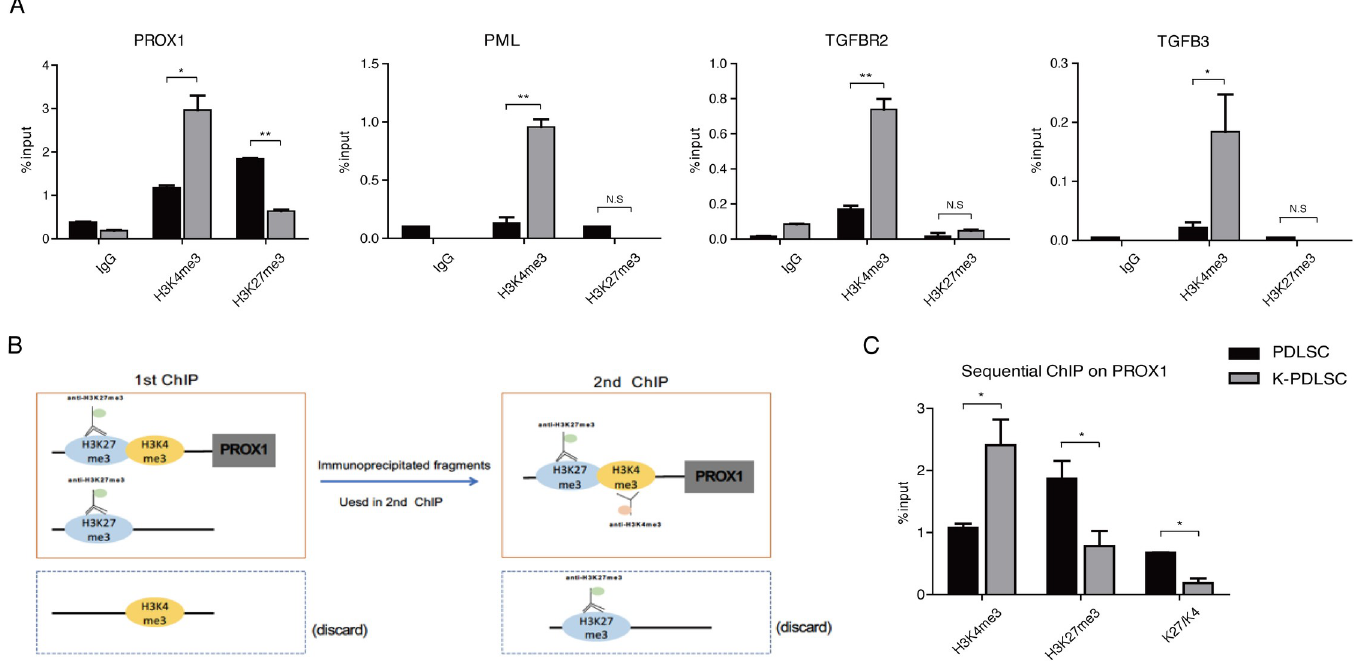
Fig 3. PROX1 gene is harbored in a bivalent chromatin structure and KSHV infection can resolve it to activate PROX1 expression. (A) Mock- and KSHV-infected PDLSCs were subjected to a Chromatin immunoprecipitation (ChIP) assay with antibodies against H3K4me3 and H3K27me3. The extracted DNA was analyzed by qPCR for the PROX1 promoter region and other MEndT-related genes, including PML, TGF- β R2 and TGF- β 3. PROX1 gene in mock-infected PDLSCs heavily consists of both active mark H3K4me3 and repressive mark H3K27me3, exhibiting a distinctive bivalent chromatin domain. (B) Schematic illustration of the sequential ChIP assay. Cross- linked chromatin from MSCs was immunoprecipitated with an anti-H3K27me3 antibody followed by a second immunoprecipitation with an anti-H3K4me3 antibody. (C) The extracted DNA was analyzed by qPCR with primers of the PROX1 promoter, and the result showed that H3K4me3 and H3K27me3 co-exist in the same nucleosome in the PROX1 promoter. Error bars represent SD. Statistics analysis was performed using one-way ANOVA test, and P-value was calculated by GraphPad Prism. P-value < 0.05 was considered significant ( � P < 0.05, �� P < 0.01 and ��� P < 0.001) and N.S represented no significance.